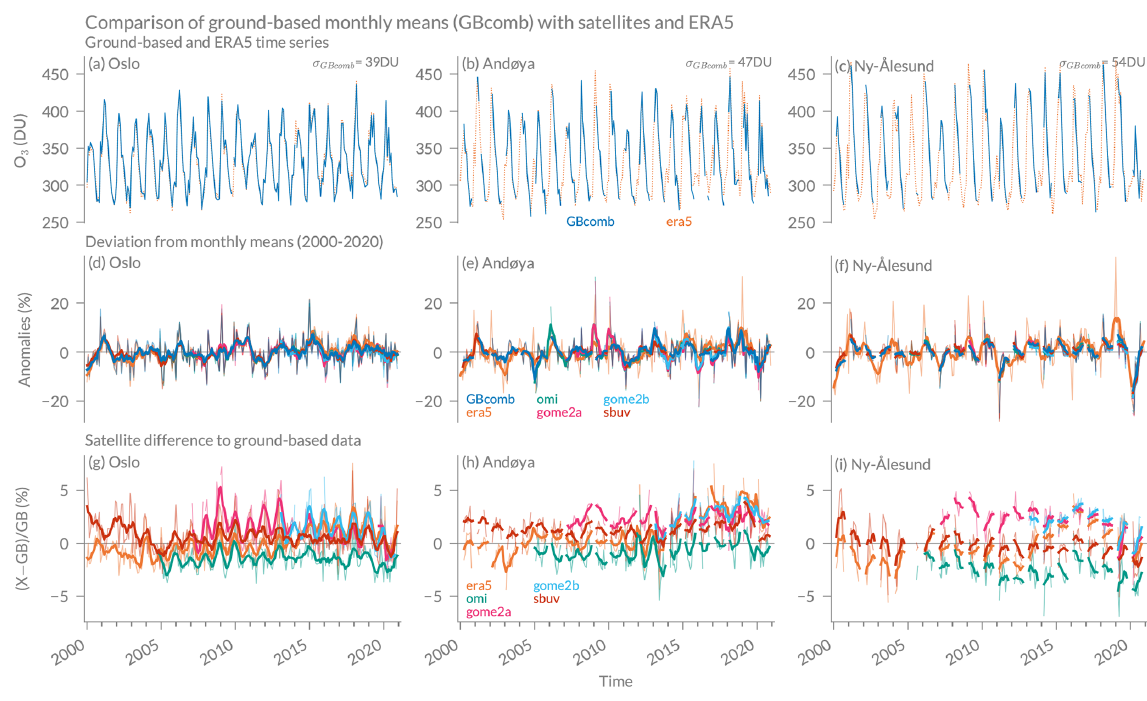
Figure 3. Comparison of the combined ground-based data (GBcomb) with satellite overpasses and ERA5 data at the three stations Oslo, Andøya, and Ny-Ålesund. The first row ( a–c ) shows monthly means of the ground-based data together with ERA5 monthly means. The standard deviation of GBcomb data ( σ GBcomb ) is also given. The second row ( d–f ) shows relative anomalies for each dataset, which are defined as the deviation of each month from the monthly mean climatology (2000–2020) of the respective dataset. The third row ( g–i ) shows monthly differences between GBcomb and coincident daily means of the other datasets. The thick lines in panels (d) – (i) show data smoothed with a moving window of 6 months (with a minimum window size of 3